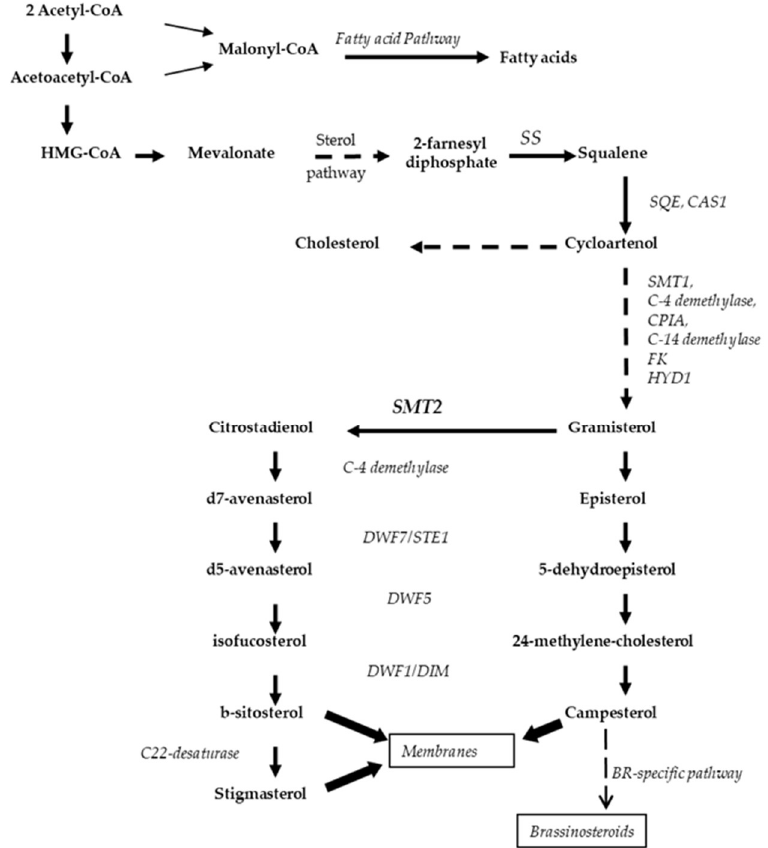
Figure 5. Simplified hypothetical relationships between sterol and fatty acid biosynthesis pathways in Asteraceae. CAS1: CycloArtenol Synthase; CPI1: CycloPropyl Isomerase; FK: C14 reductase; HYD1: C8,7 isomerase; DWF7/STE1: Δ 7 sterol C5 reductase; DWF5: Δ 7 sterol C-7 reductase; DWF1/DIM: C24